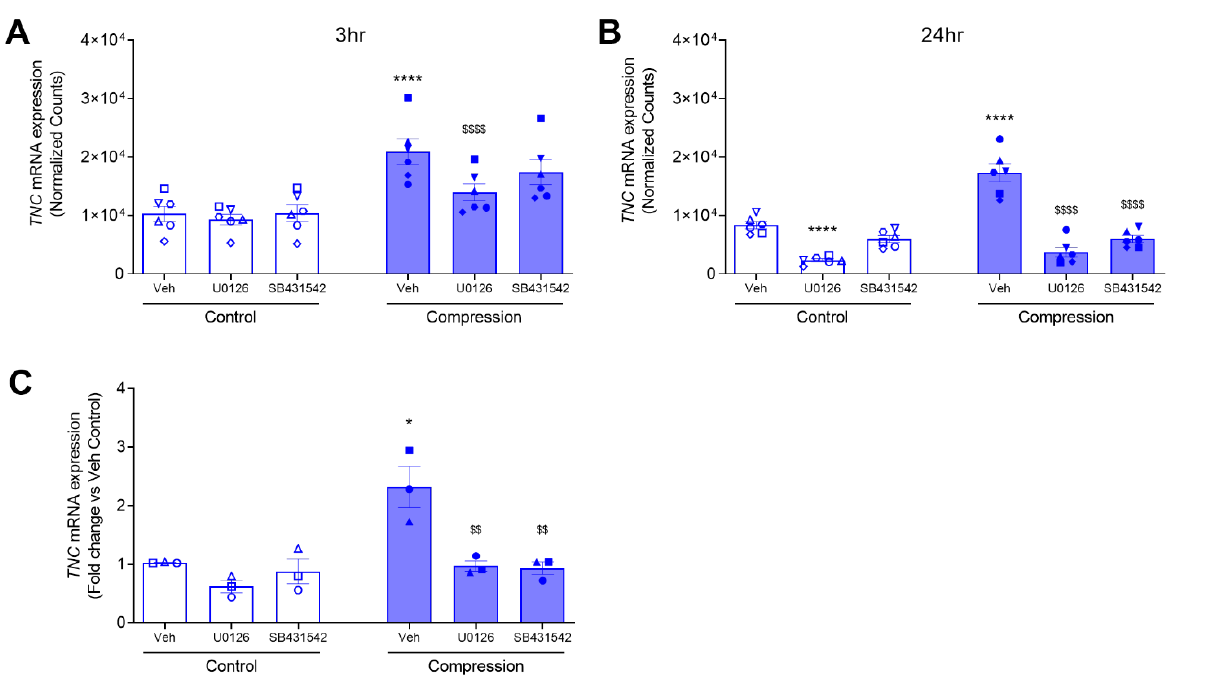
Figure 2. Compression-induced TNC mRNA expression depends on TGF- β receptor and ERK pathways. Expression plots showing normalized gene expression levels of TNC at 3 h ( A ) and 24 h ( B ) in compressed HBE cells in the absence or presence of either U0126 or SB431542 (mean ± SD, 6 non-asthma donors). TNC mRNA expression was validated by qRT-PCR and normalized to GAPDH (mean ± SEM, 3 non-asthma donors) ( C ). * p < 0.05, **** p < 0.0001, significantly different from time- matched no pressure control, $$ p < 0.01, $$$$ p < 0.0001, significantly different from vehicle with pressure, analyzed by two-way ANOVA with Bonferroni’s post-hoc test. Each symbol represents each of the six ( A and B ) or four ( C ) donors. The open symbols represent control condition, and the closed symbols represent compressed condition in non-asthmatic HBE cells (blue symbols; A , B and C ).